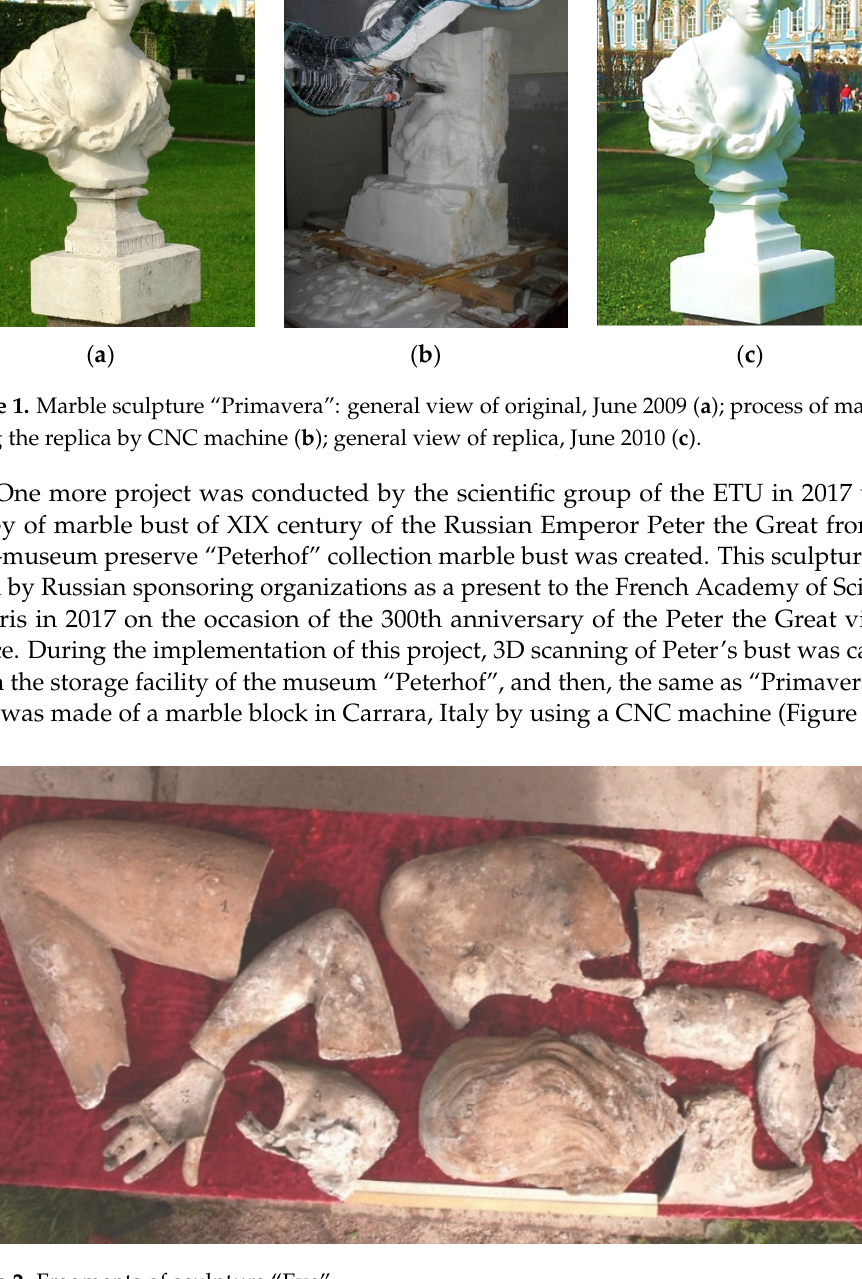
Figure 2. Fragments of sculpture “Eve”.